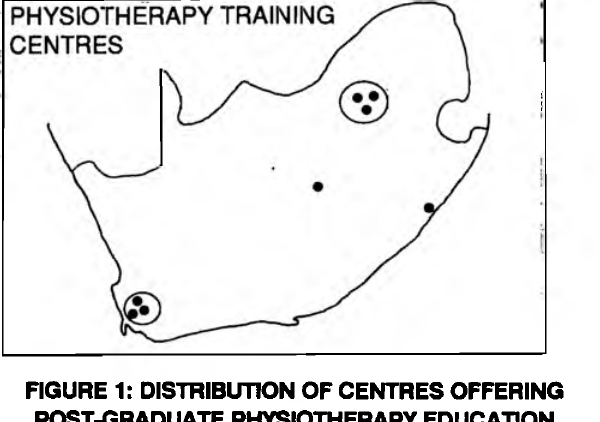
FIGURE 1: DISTRIBUTION OF CENTRES OFFERING POST-GRADUATE PHYSIOTHERAPY